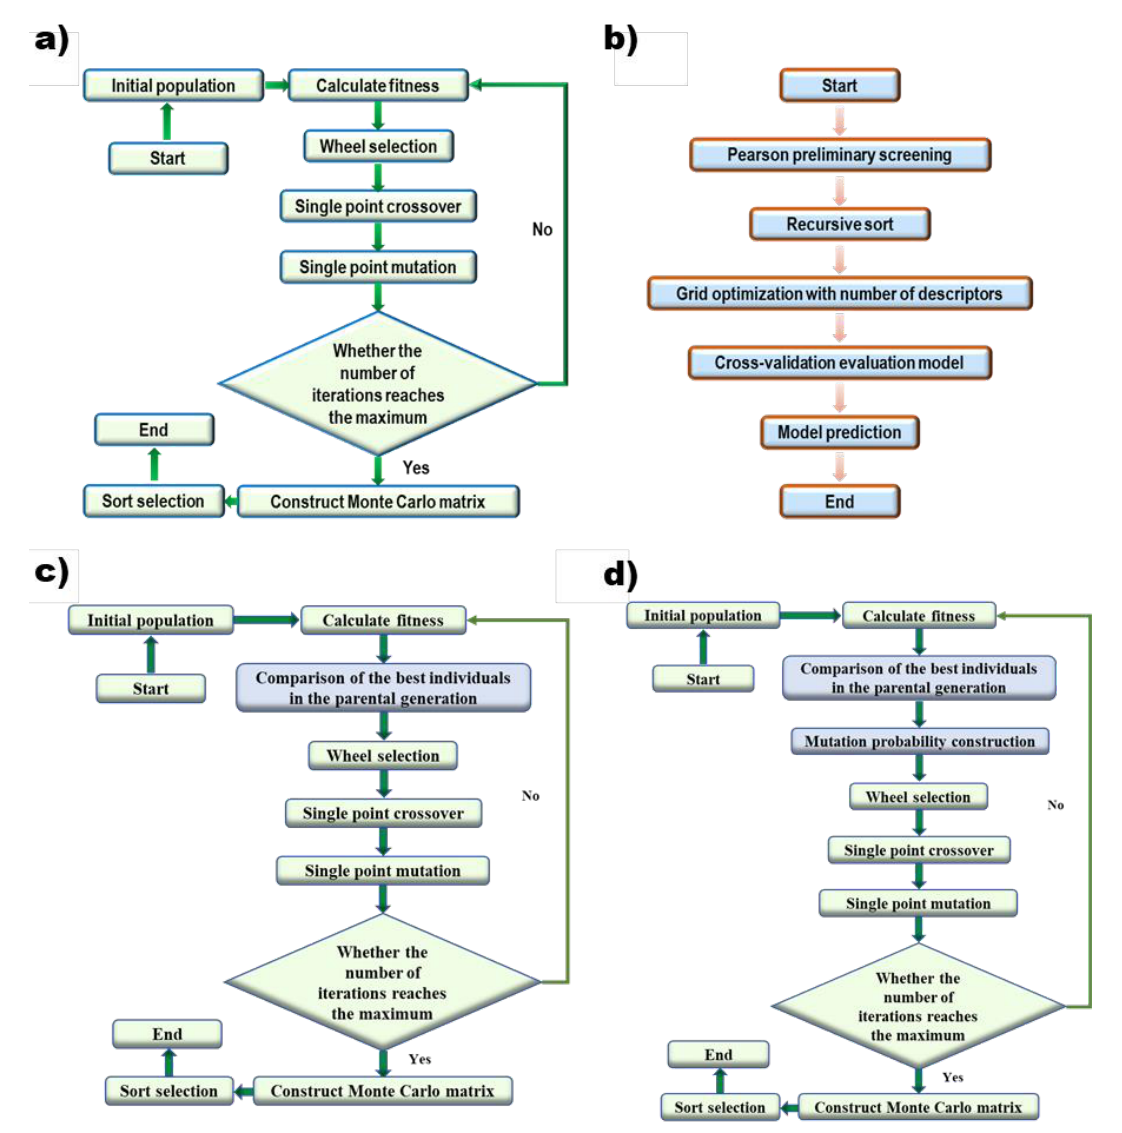
Figure 1. Algorithm flow of ( a ) Genetic Algorithm, ( b ) Grid Search, ( c ) GA with the elite retention method, and ( d ) GA with the mutation-selection strategy based on evolutionary history.